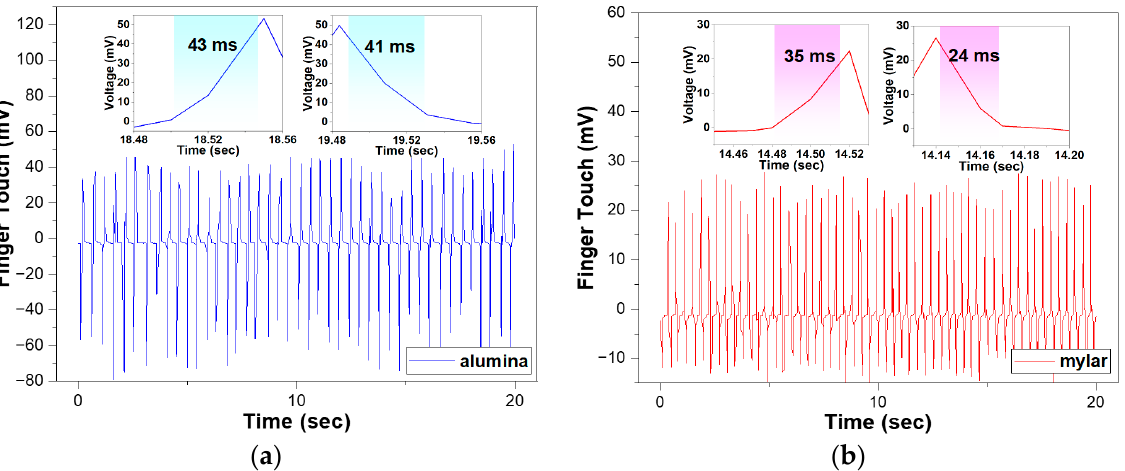
Figure 10. Output voltage and response time (inset: rising time and falling time) of the 0-3 PZT–PVB composite sensor to finger touch: ( a ) alumina substrate; ( b ) mylar substrate.